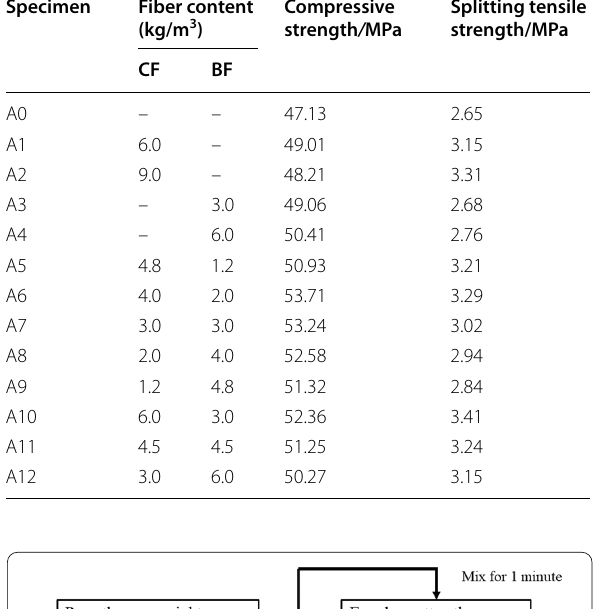
Fig. 2 Grading curve of machine-made sand.